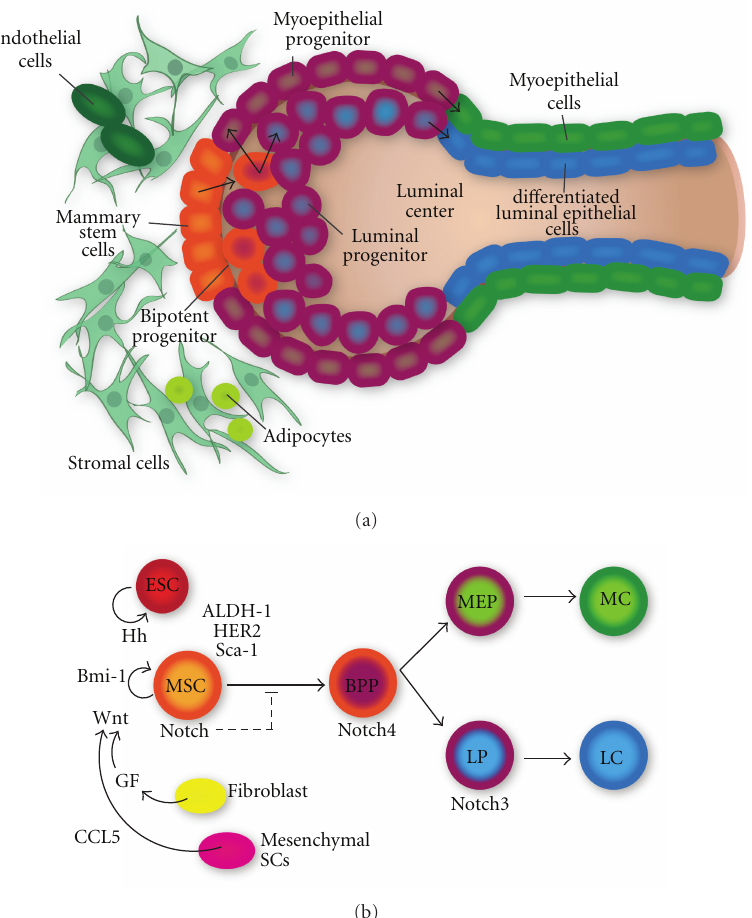
Figure 3: Model of the breast stem cell niche including structural elements (left panel) and mathematical model (right panel). Key populations of the mammary stem cell niche include mammary stem cells (MSCs), mesenchymal stem cells, endothelial stem cells (ESCs), bipotent progenitor (BPP), luminal progenitor (LP), myoepithelial progenitor (MEP), myoepithelial cells (MCs), luminal epithelial cells (LCs), and stromal cells. Wnt, Notch, and Hedgehog (Hh) signaling play a role in MSC self-renewal. Regulatory signals from growth factors (GFs) secreted by fibroblasts and CCL signaling from mesenchymal stem cells also regulate MSC